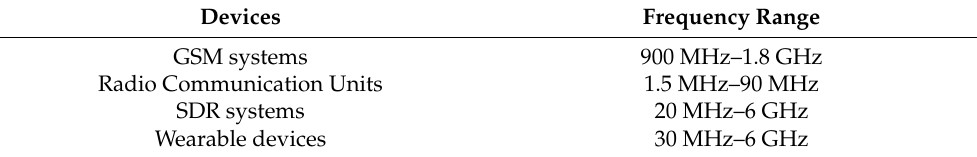
Table 2. Communication devices and relative frequency